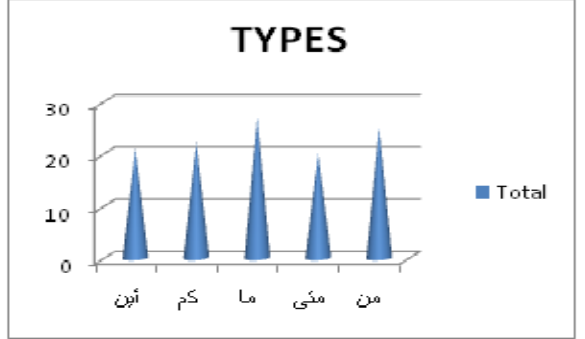
Figure 2. Some examples of questions used in our corpus